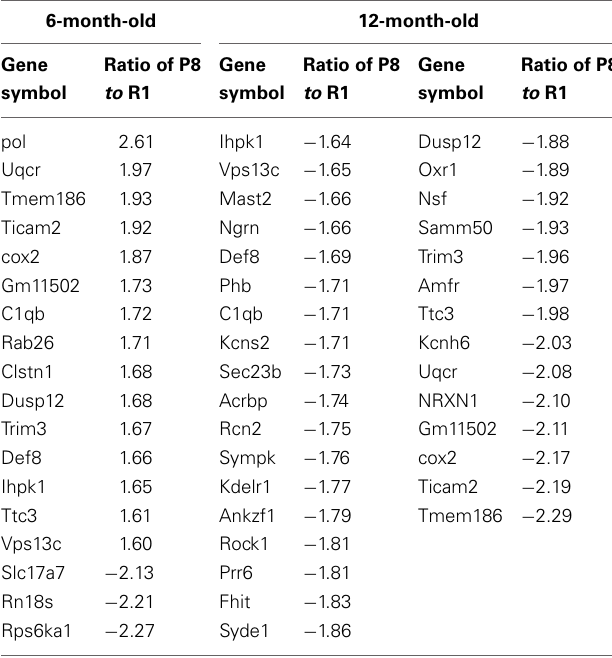
Table 2 | Differentially expressed genes in the cerebral cortex of SAMP8 and SAMR1 with aging ∗